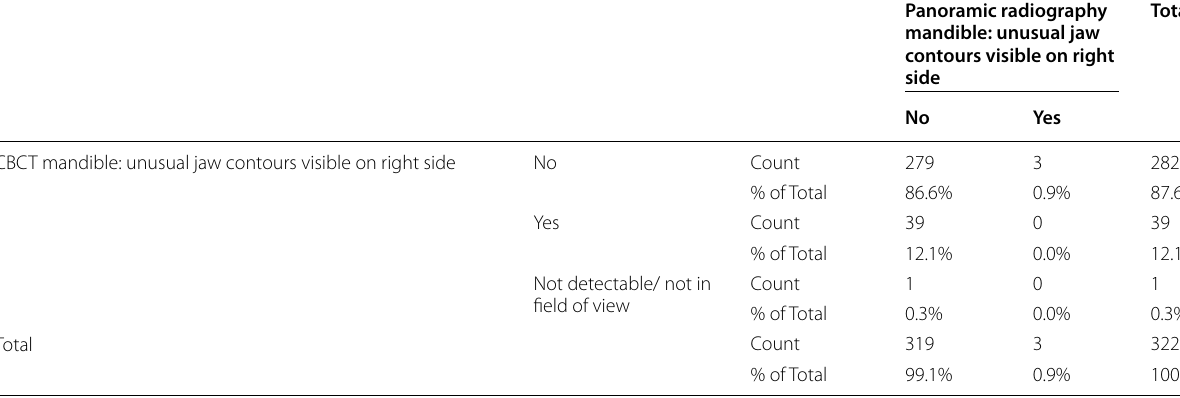
Table 4 Contingency table, in per cent of unusual jaw contour, of the right mandible